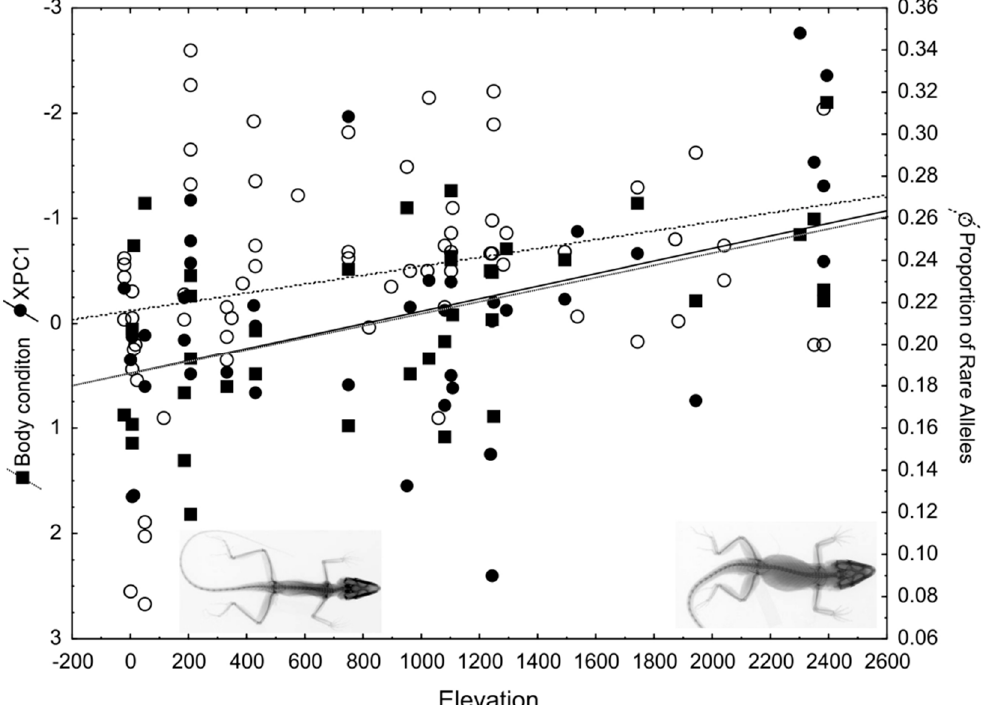
Figure 5. The covariation of rare allele frequencies of outlier RADseq SNPs with phenotypic adaptation to elevation (in meters above sea level). The transformed (residual to SVL and summarized via a principal component analysis) phenotypic variables (Wollenberg et al., [36]) representing body condition (relative body mass = snout-vent length/weight in g), and XPC1 (relative bone length, the variable shows shorter bones as larger values and is thus plotted inverse). The inset images show X-rays of typical lowland phenotypes of A. cybotes (left), and highland A. cybotes (right, own images). From Rodriguez et al. (2017) [391], under the Creative Commons license.